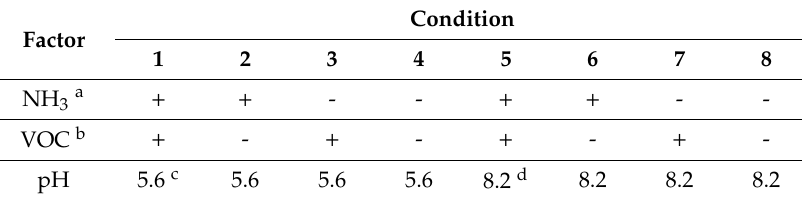
Table 1. Conditions chosen for testing the involvement of multiple factors interaction for Rhizoctonia solani growth inhibition. Condition Factor 1 2 3 4 5 6 NH 3